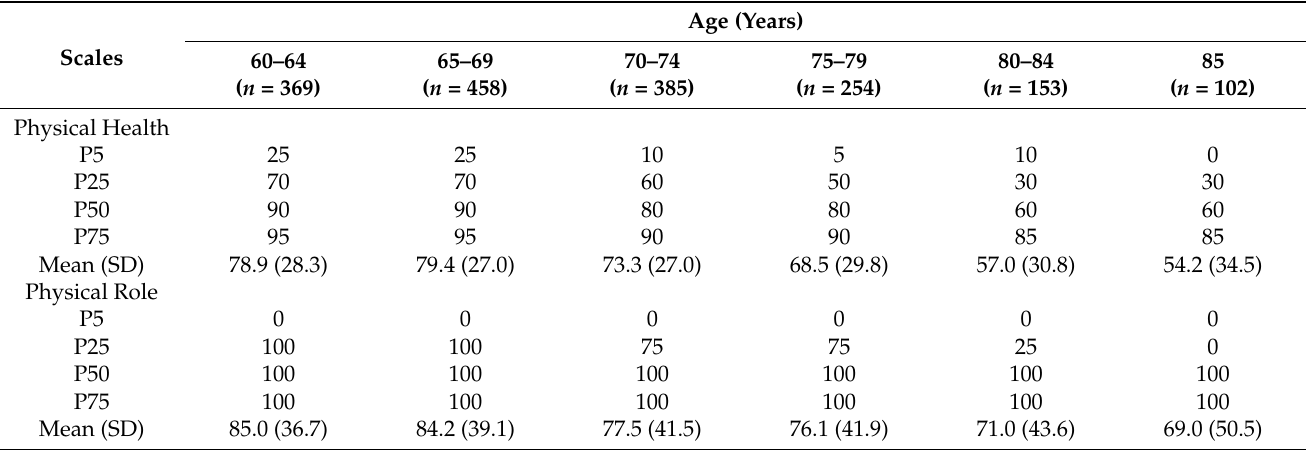
Table A4. Scores of the SF-36 Health Questionnaire Scales by Age in the Control Population. Adapted from L ó pez-Garcia E